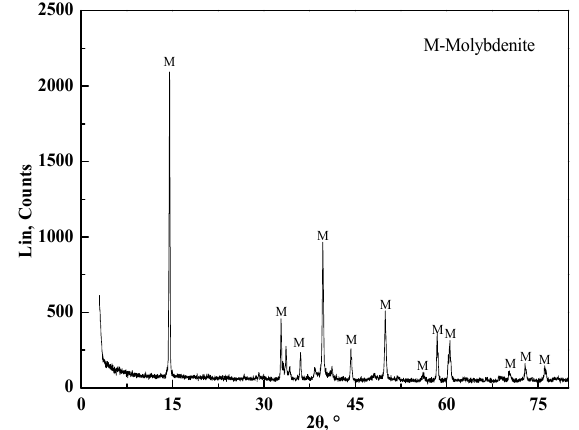
Figure 1. XRD analysis of molybdenite.